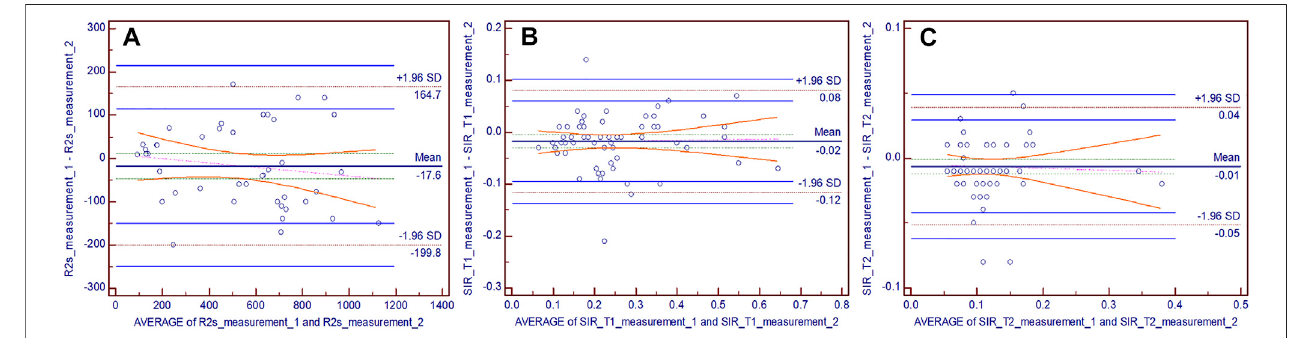
FIGURE 5 | Bland – Altman difference plots for R2* (A) , hepatic muscle signal ratio (SIR)_T1 (B) , and SIR_T2 (C) measurements generated by two independent readers. The dotted red lines demarcate the 1.96 standard deviations (SD), and the blue lines depict their 95% prediction limits.